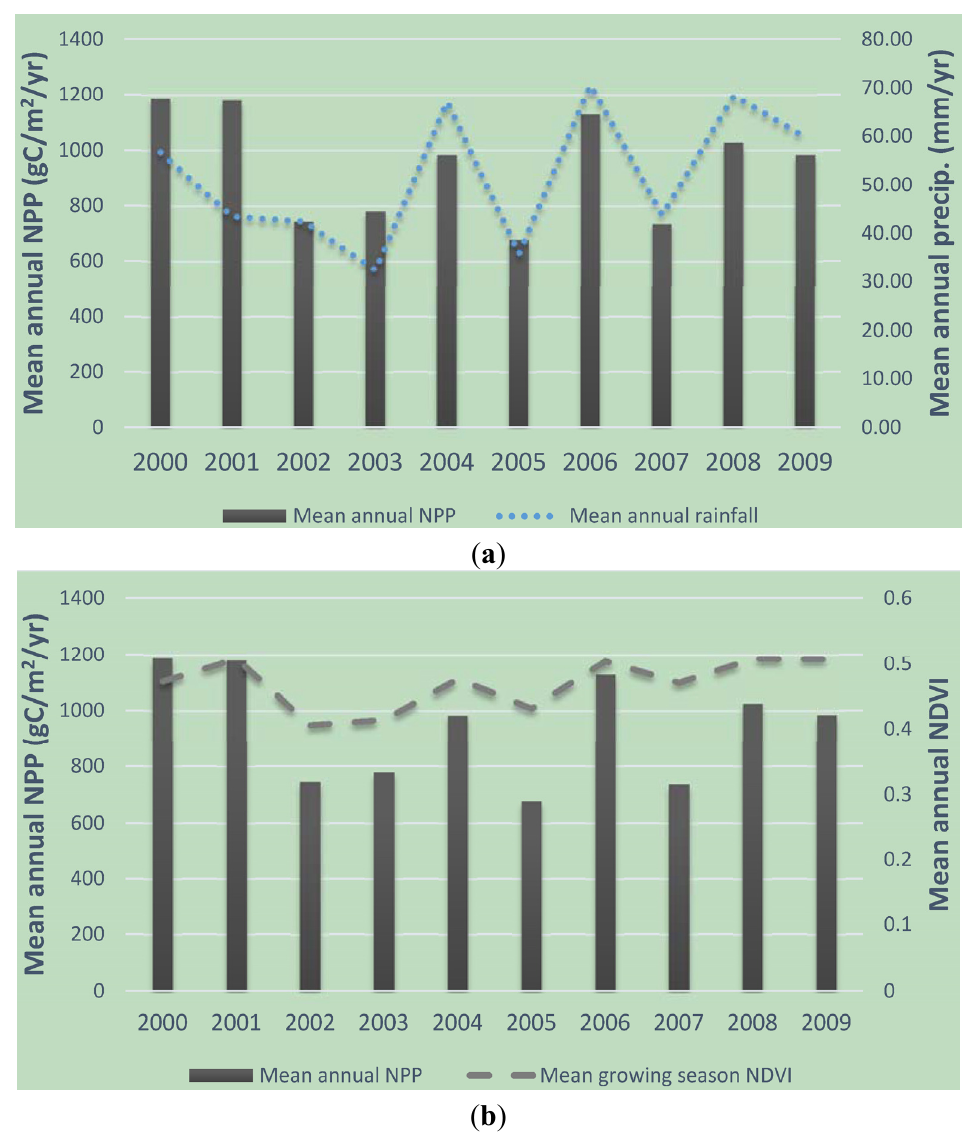
Figure 3. ( a ) Mean annual net primary productivity (NPP) values from 2000 to 2009 based on the C5 MOD17A3 collection (reprocessed after Zhao and Running, 2010) relative to mean annual rainfall data from the Tropical Rainfall Measuring Mission (TRMM 3B43) for 2000 to 2009 for the CRB; mean r = 0.65 and ( b ) Mean annual NPP and the mean growing season NDVI for 2000 to 2009; mean r =